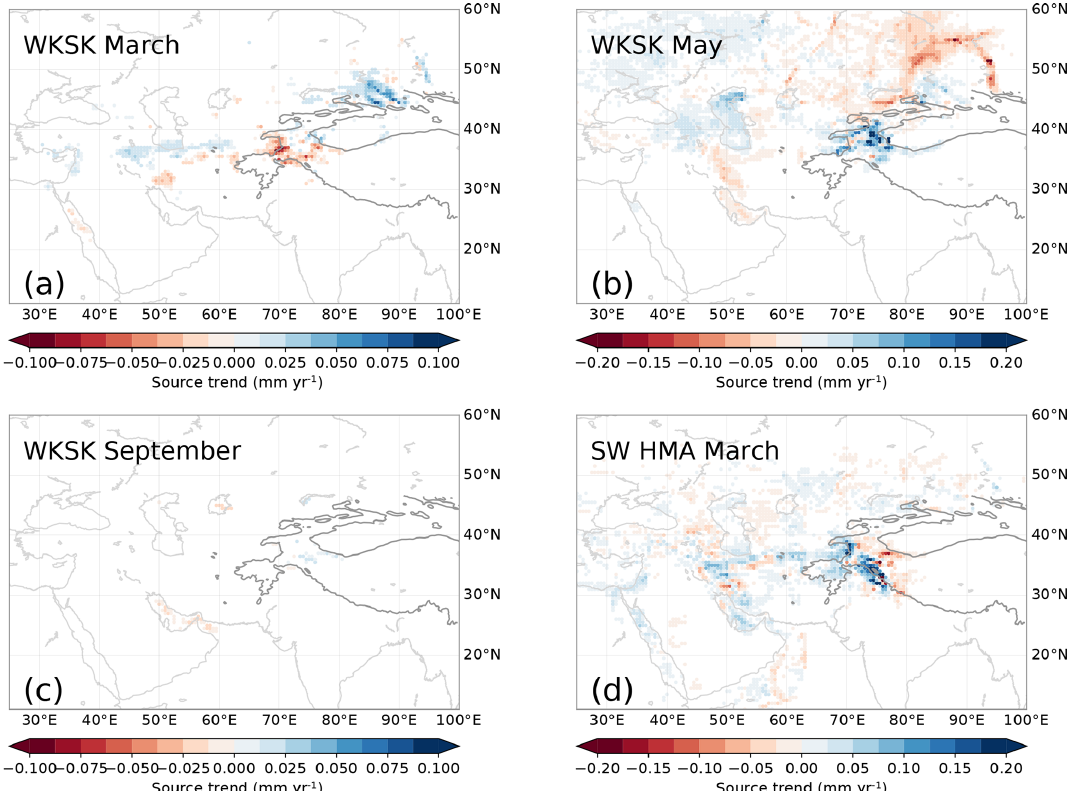
Figure 15. Trends in the amount of moisture from a given source for the WKSK for March (a) , May (b) , and September (c) and for south- western HMA in March (d) . These months correspond to large negative or positive trends in snowfall in Fig. 10. Note the different